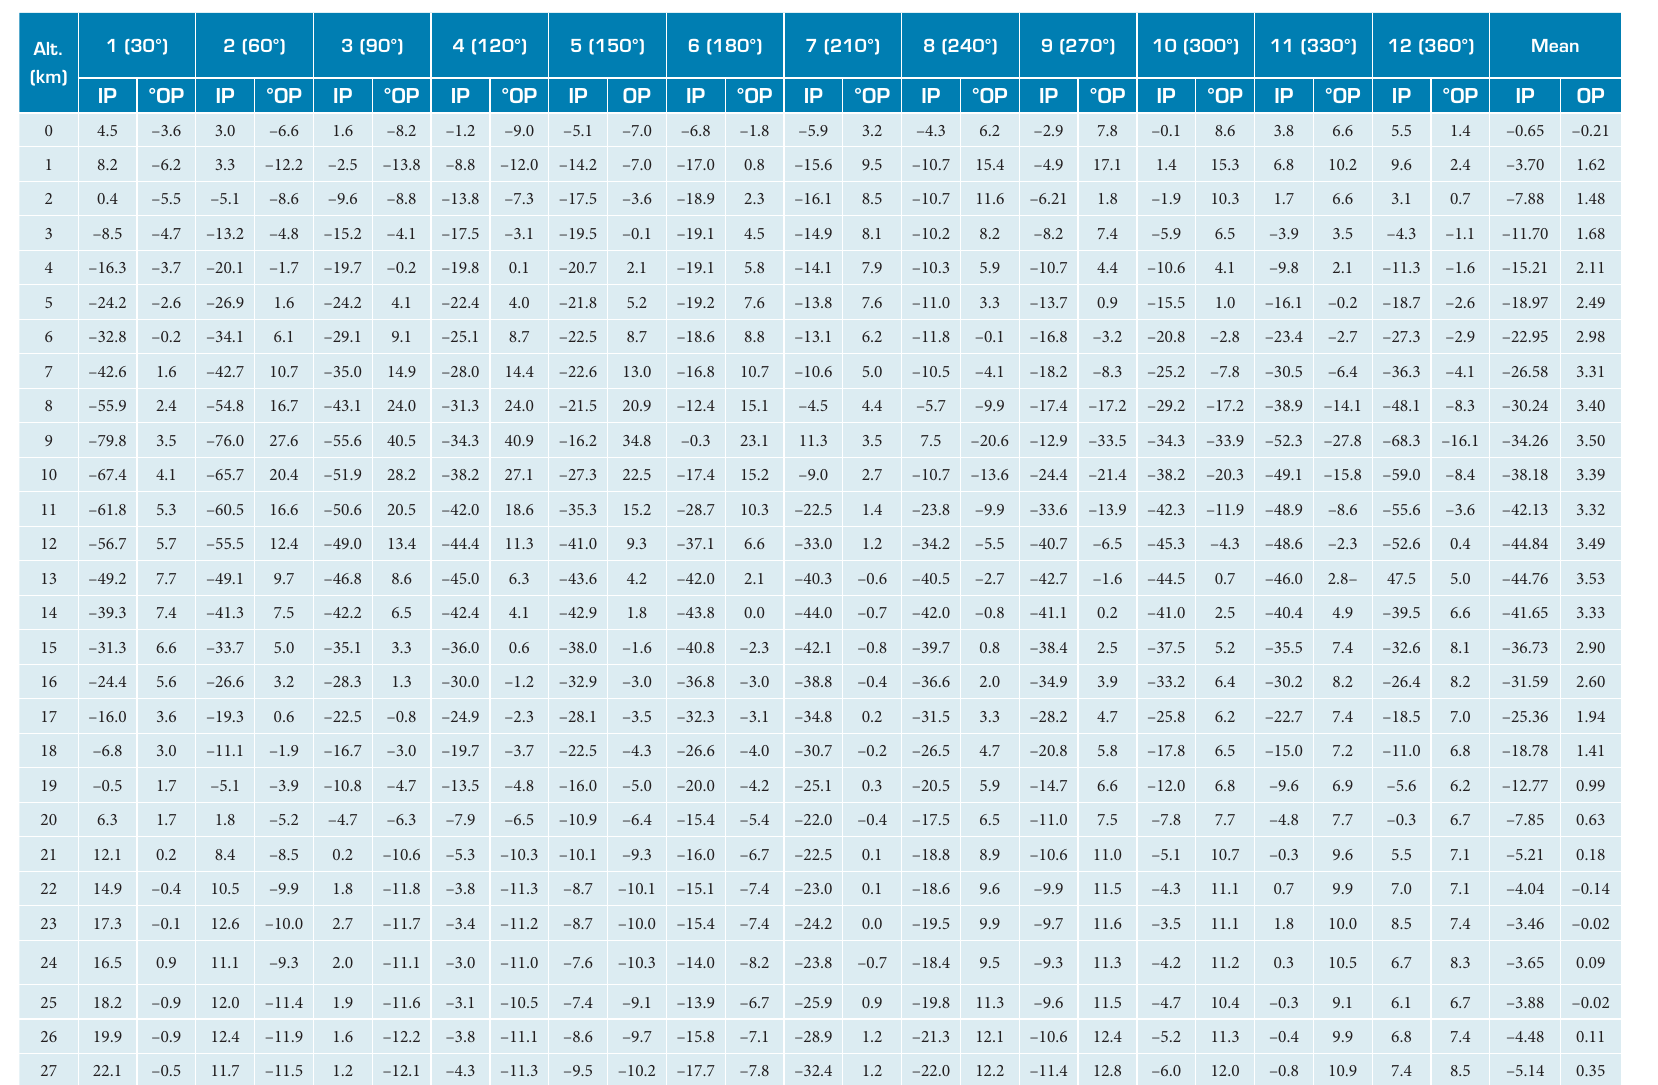
Table 2. KSC worst month (February) VWP model design wind component profiles giving the 12 vector wind model synthetic profiles for each 30° clock angle plus mean profiles (reference height = 5 nm – 9 km –, IP and OP wind components (m/s), for flight azimuth = 90°). After the first column, all units are m/s (1 m/s = 3.281 ft/s; 1 km = 0.54 nmi).